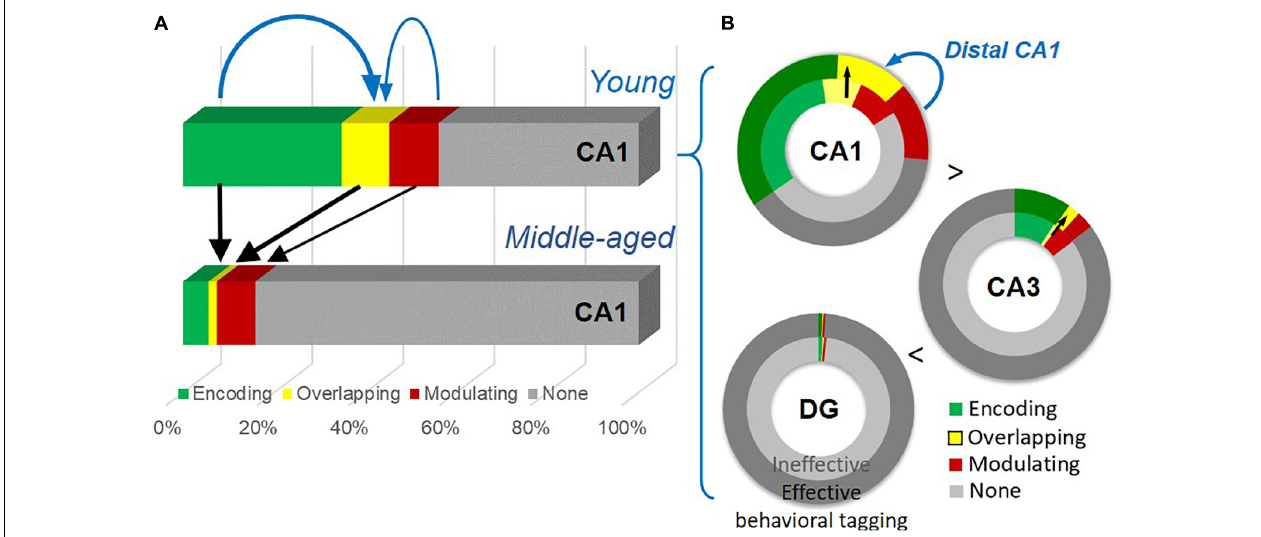
FIGURE 9 | A summary of the age-dependent neuronal changes and the gradient of neuronal engagement in subregions of the hippocampus. (A) Neuronal activation by the encoding, by both events (thick black arrows), and by the modulating event (a thin black arrow) shows significant reduction with age. The encoding population (a thick blue arrow), compared to the modulating population (a thin blue arrow), is preferentially more correlated with the overlapping population. (B) Effective behavioral tagging in young animals leads to more overlapping population (black arrows) in CA1 and CA3. There is a gradient of active cell populations from DG to CA1. The modulating population (a blue arrow) is correlated with the overlapping population in distal